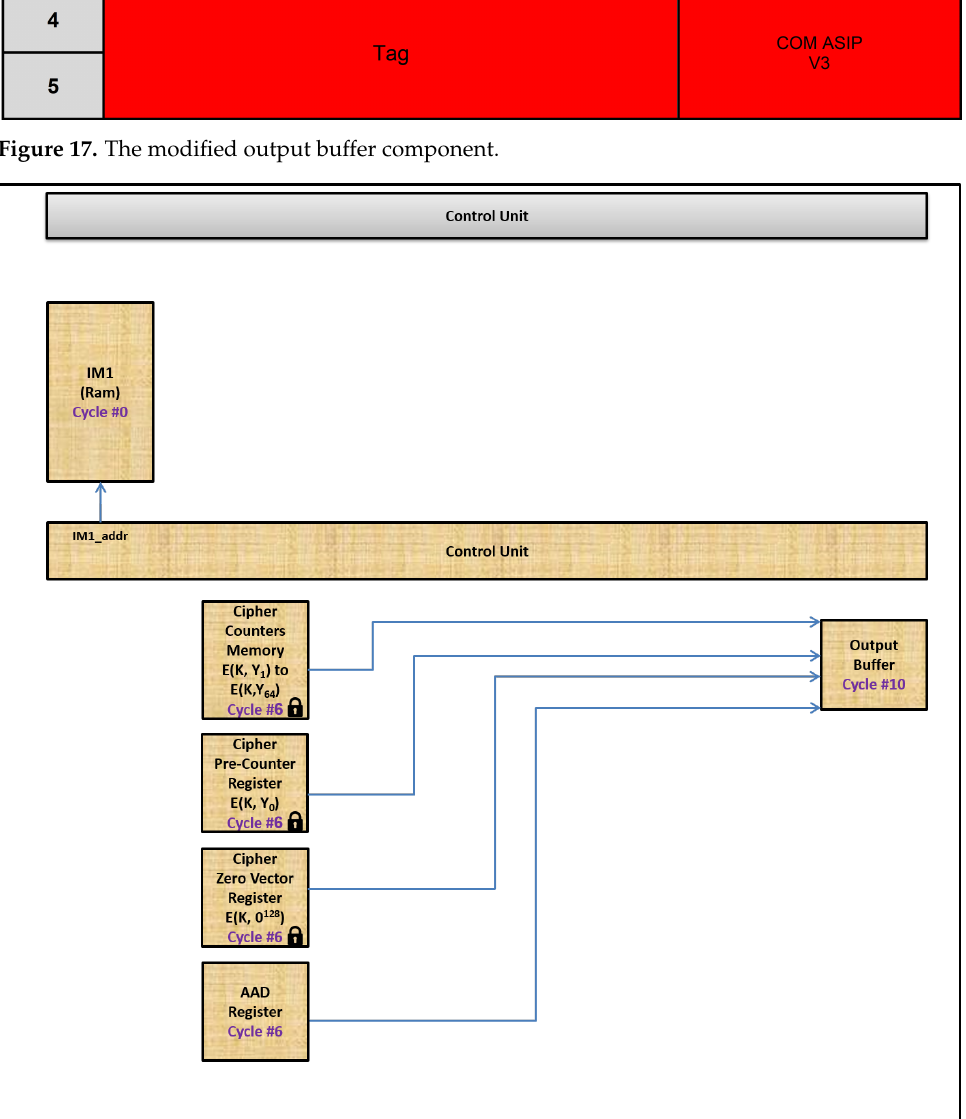
Figure 18. The additions to AUTOSAR COM ASIP to support the hashing